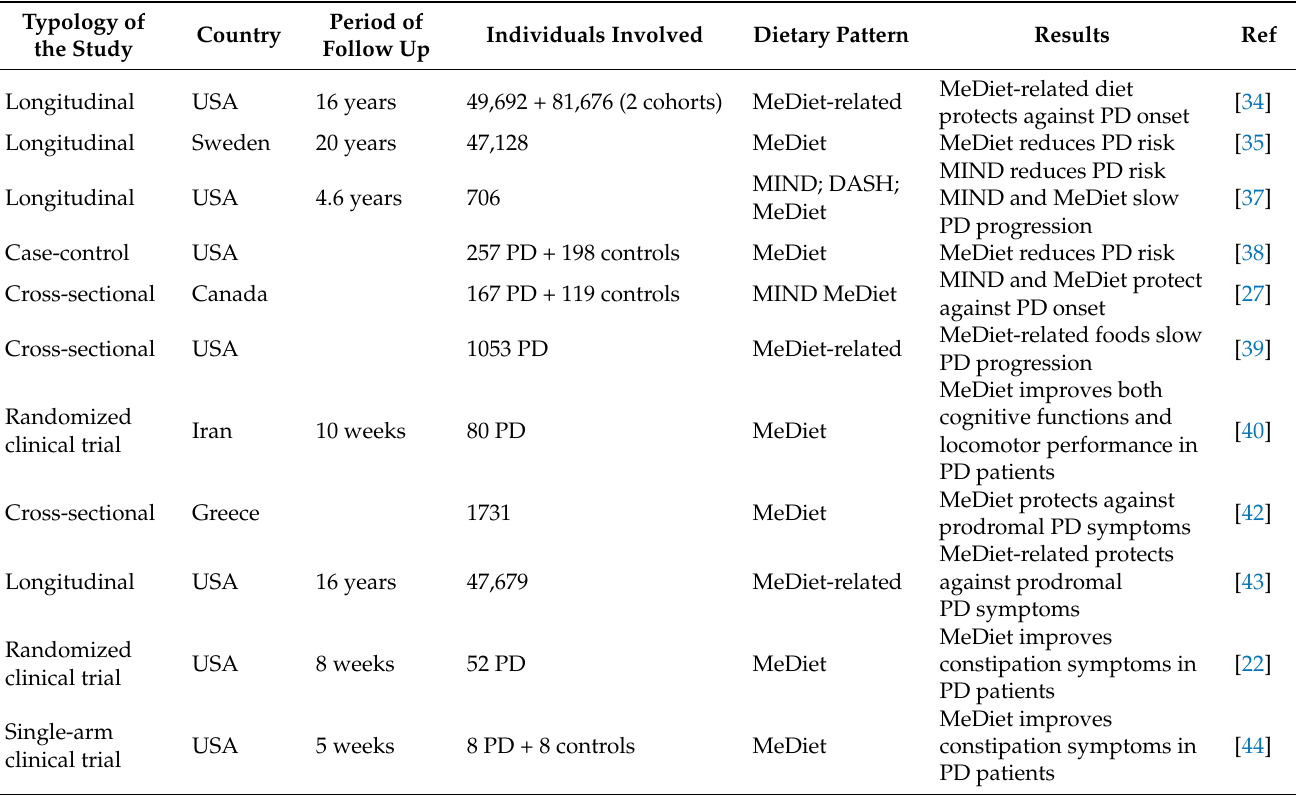
Table 2. Clinical trials evaluating the effects of the MeDiet on